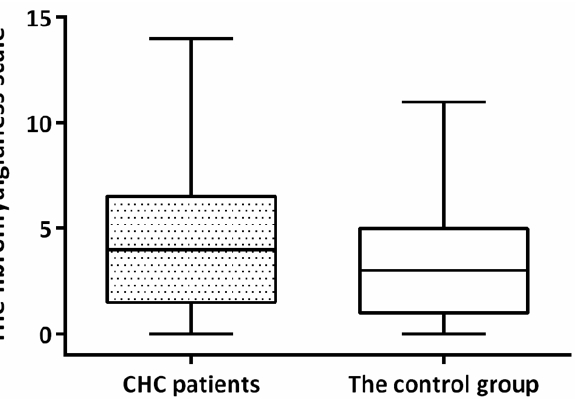
Figure 1. Comparison of fibromyalgianess between CHC patients at baseline and controls. CHC, chronic hepatitis C.